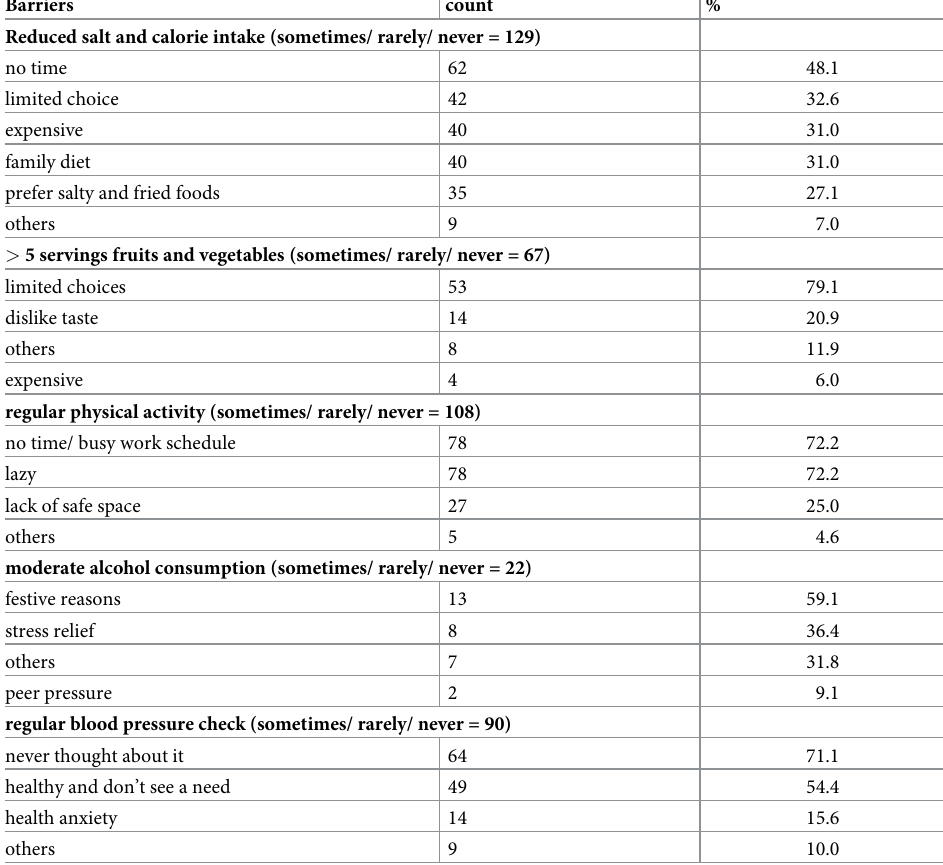
Table 5. Barriers against hypertension self-care behaviours. Barriers were obtained from participants whom ‘some- times’ or ‘rarely/never’ carry out these behaviours. Barriers